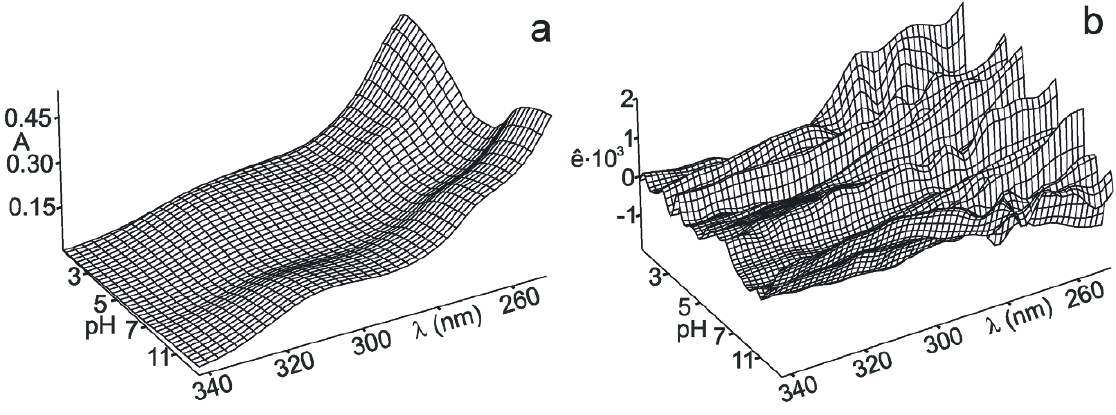
Figure 2. (a) The 3D-absorbance-response-surface representing the measured multiwavelength absorption spectra ( n = 46, m = 19) for 4.2×10 -5 mol dm -3 vardenafil depending on pH at 25°C, (b) the 3D-residuals map after a non-linear regression performed with SPECFIT/32 program, (S-Plus).